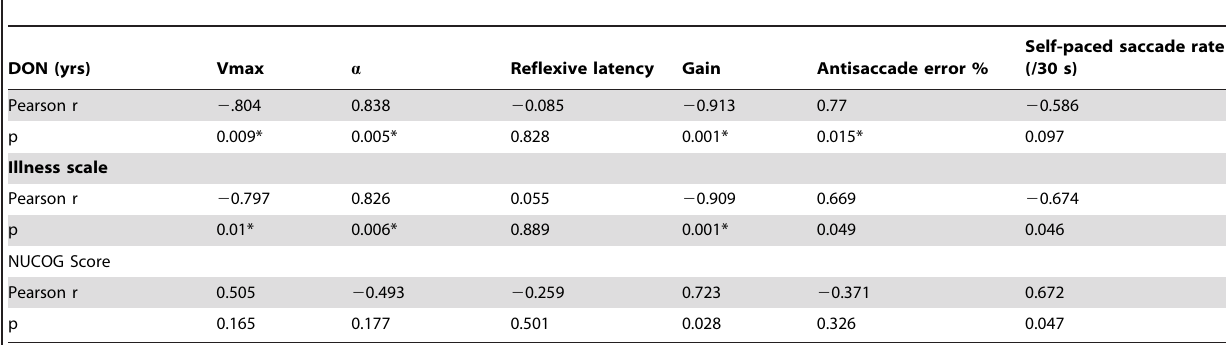
Table 2. Correlations of saccadic parameters with illness duration and severity measures.